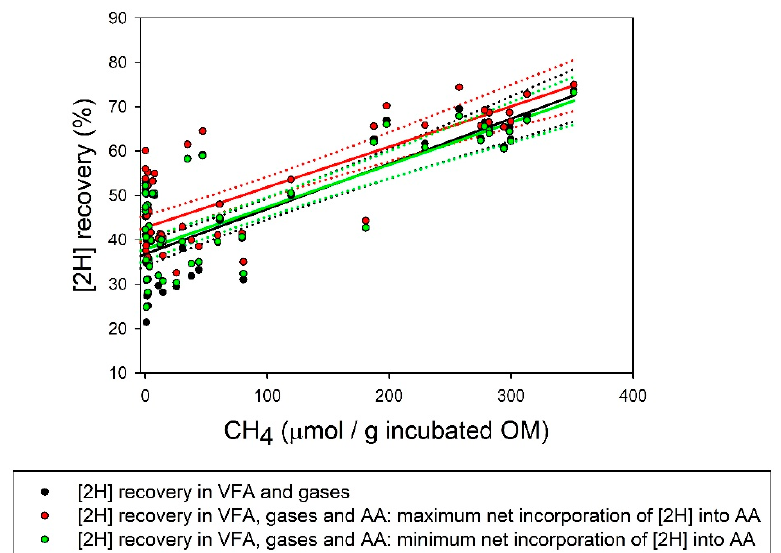
Figure 1. Response of recovery of reducing equivalents ([2H]) (%) to methane (CH 4 ) produced per gram of organic matter (OM) incubated. Solid lines represent responses and dotted lines are 95% confidence bands. [2H] recovery (%) into: (i) Volatile fatty acids (VFA) and gases: • y = 36.9 (±1.24; p < 0.001) + incubation (random, p = 0.46) + 0.10 (±0.010; p < 0.001) x ; R 2 = 0.66; (ii) VFA, gases and amino acids (AA) with maximum incorporation of [2H] into AA synthesis: • y = 42.6 (±2.11; p < 0.001) + incubation (random, p = 0.41) + 0.089 (±0.0095; p < 0.001) x ; R 2 = 0.69; (iii) VFA, gases and AA with